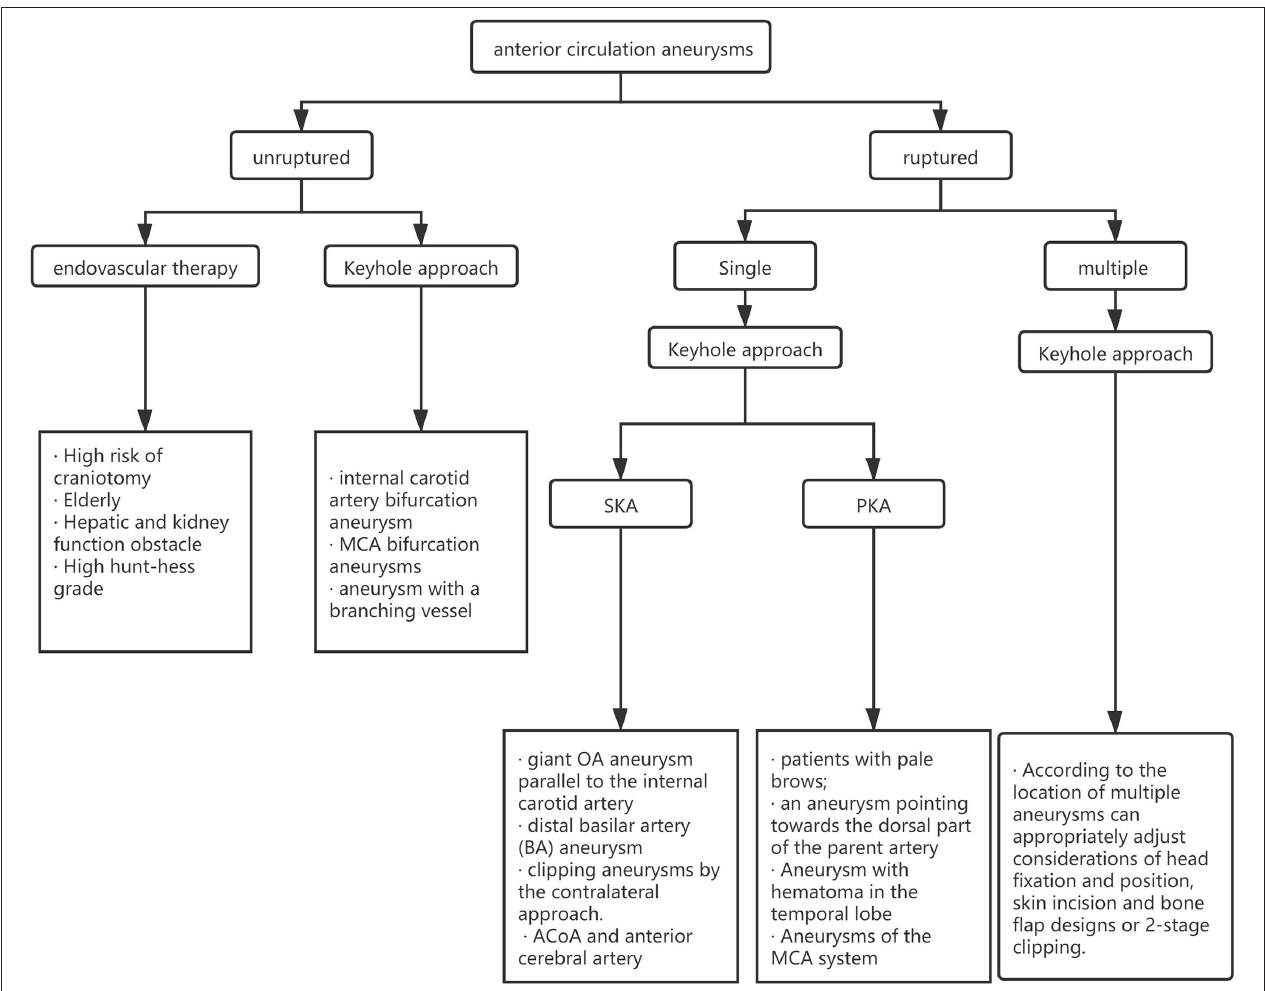
FIGURE 4 | A clinical algorithm guiding clinicians to choose the best